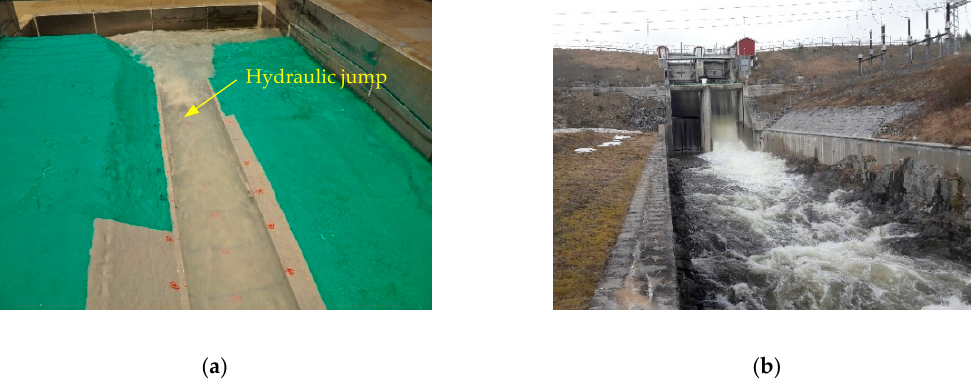
Figure 9. Supercritical flow in the spillway channel: ( a ) in the hydraulic model with hydraulic jump at the channel end; ( b ) in the prototype, with the left surface spillway partially opened for discharge.